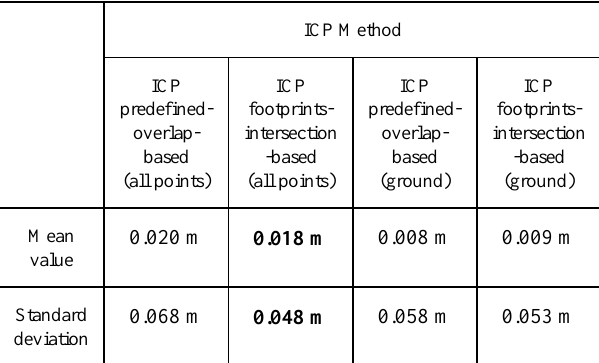
Table 4. Results of matching neighbouring scans, performed by means of different ICP